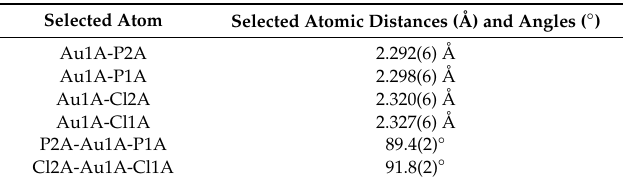
Figure 2. X-ray crystal structure of complex 2 . Depicted above is the full unit cell; two cations and two tetrachloroaurate(III) anions. All atoms are drawn at 50% probability level. Hydrogen atoms have been omitted for clarity. Table 1. Selected interatomic distances (Å) and angles (deg) from the crystal structure of complex 2 , shown in Figure 2.